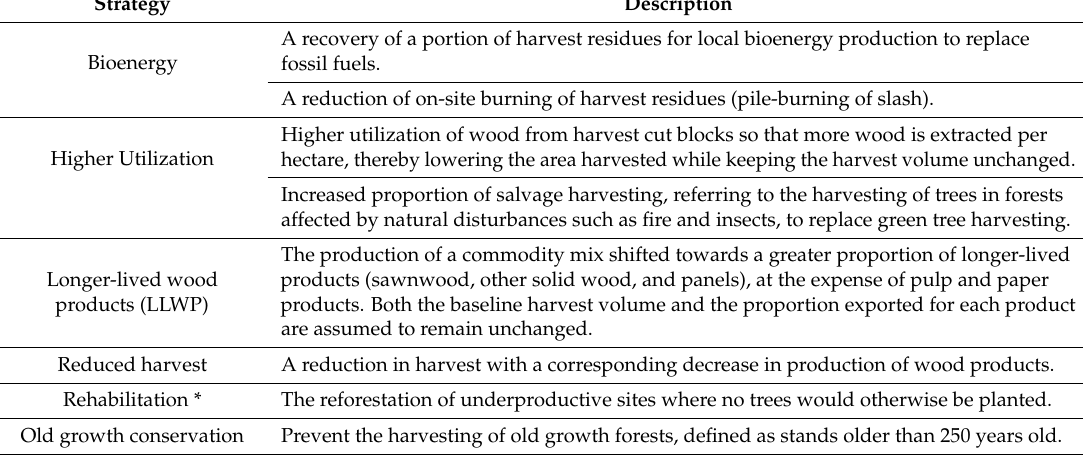
Table 1. Climate change mitigation strategies evaluated by stakeholders and Indigenous Peoples during the participatory workshops of phase